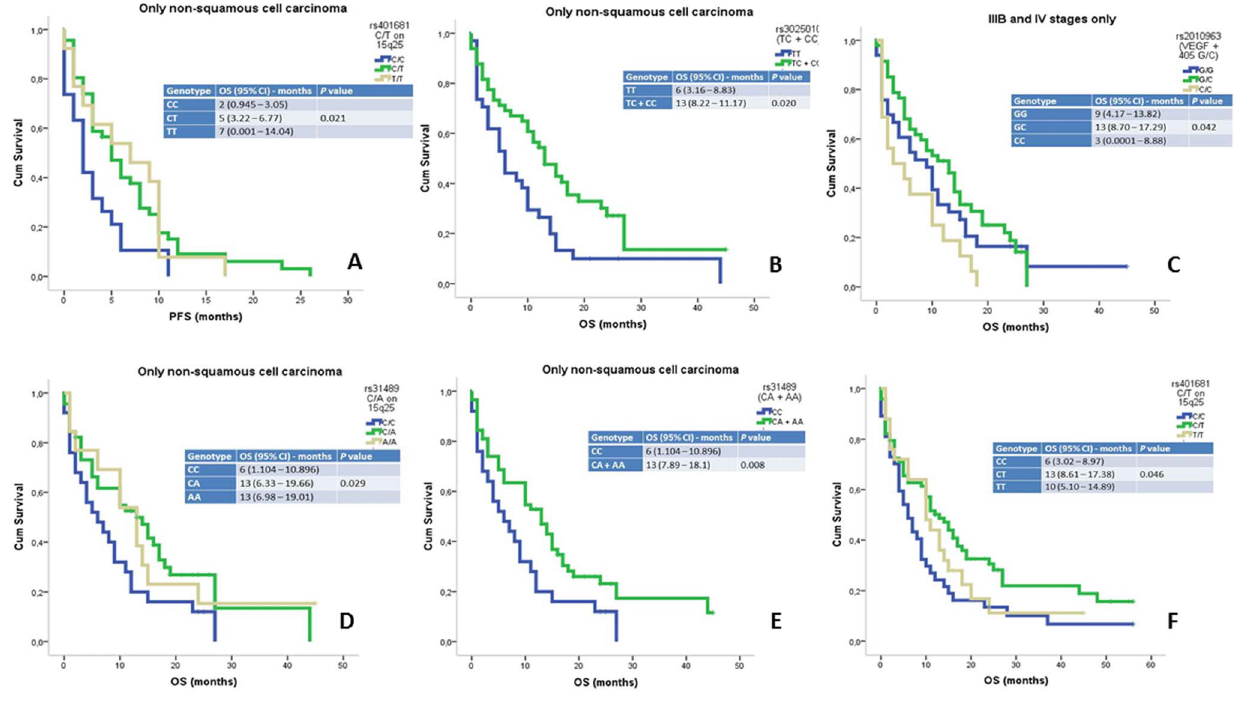
Figure 1. Progression-free survival (PFS) curve for the rs401681 C/T genetic polymorphism (A). Kaplan-Meir curve of the overall survival (OS) for the rs3025010 ( VEGF intron 5) C/T genetic polymorphisms (B). Kaplan-Meir curve of the overall survival (OS) for the rs2010963 ( VEGF + 405) G/ C genetic polymorphisms (C). Kaplan-Meir curve of the overall survival (OS) for the rs31489 C/A genetic polymorphisms (D). Kaplan-Meir curve of the overall survival (OS) for the rs31489 CA + AA genotypes versus the rs31489 CC genotype (E). Kaplan-Meir curve of the overall survival (OS) for rs401681 C/T genetic polymorphisms (F).